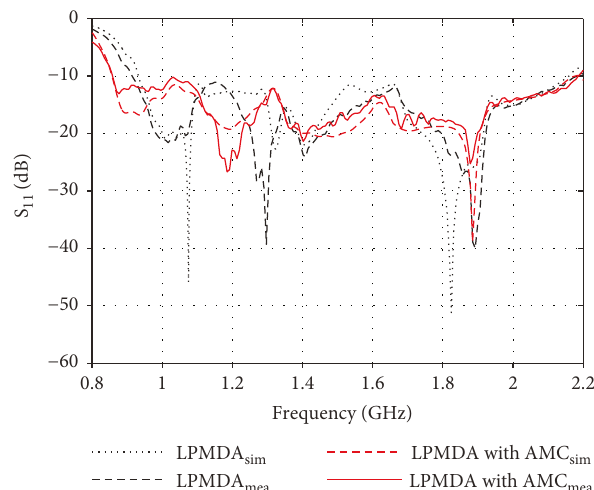
Figure 12: Simulated and measured re fl ection coe ffi cients of the proposed